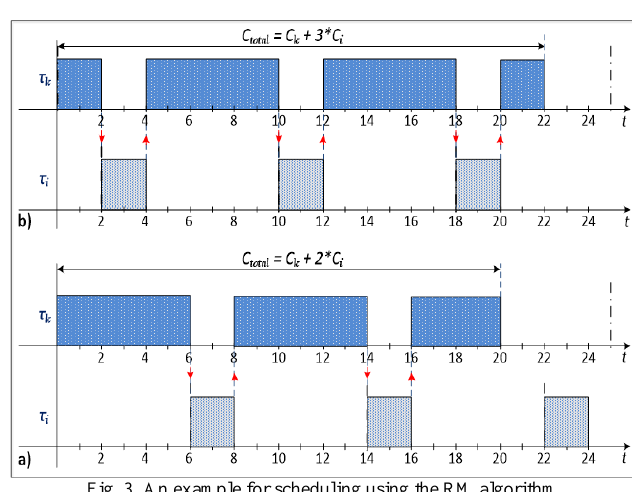
Fig. 3. An example for scheduling using the RM